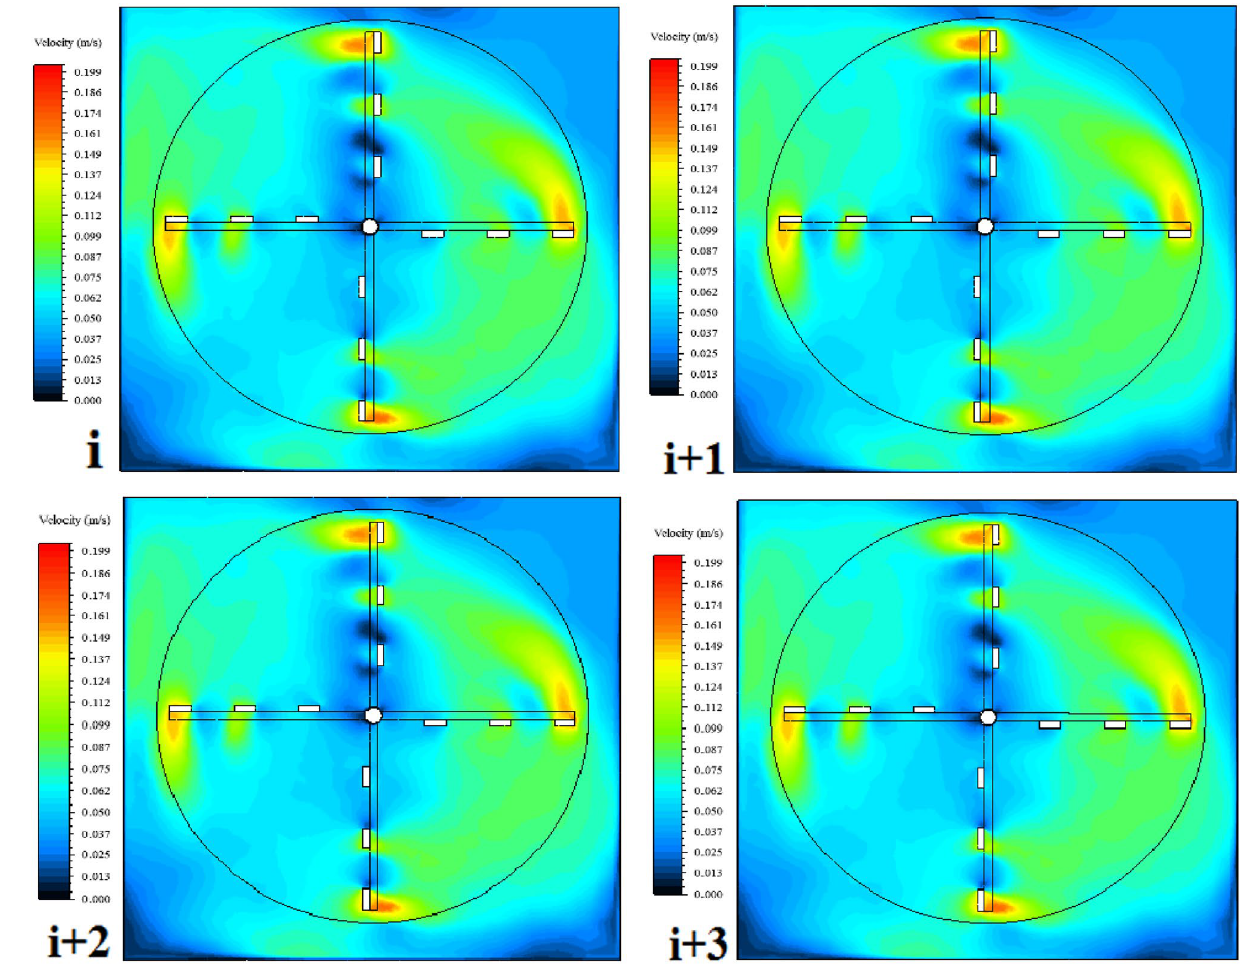
Figure 5. Similarity between CFD velocity contours generated at four consecutive Analysis of ANSYS-fluent results.